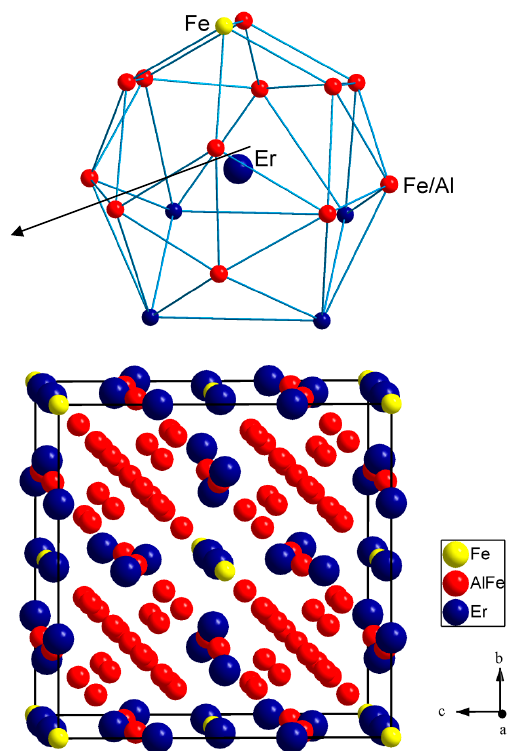
Figure 2. Crystal structure of Er 6 Fe 20 Al 3 compound and Er coordination.